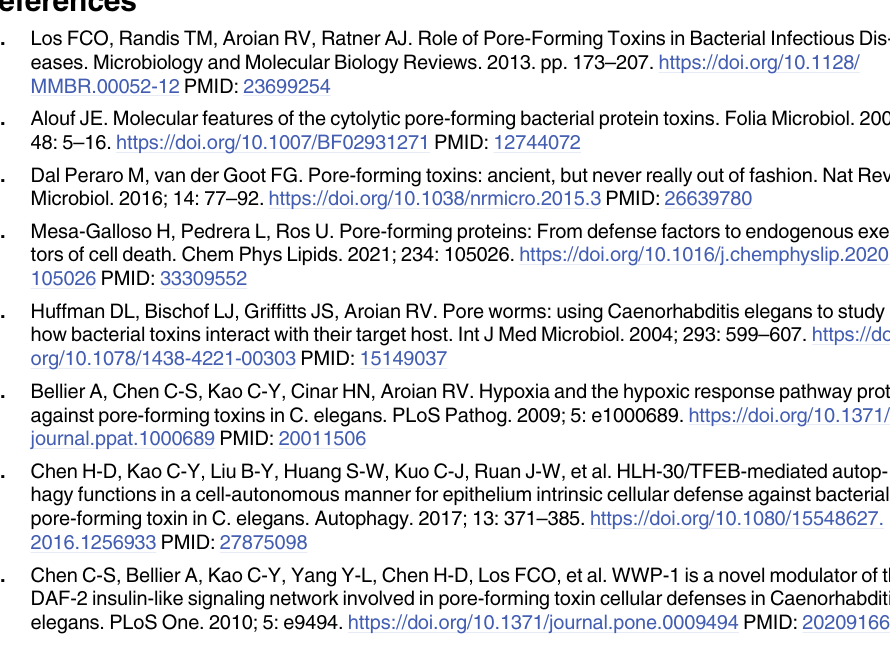
S2 Fig. N2 and nck-1(ok694) animals are not basally permeable to ingested propidium iodide. The indicated C . elegans strains were grown to the L4 stage and subjected to the normal propidium iodide feeding protocol, with no exposure to Cry5B. Scale bar =